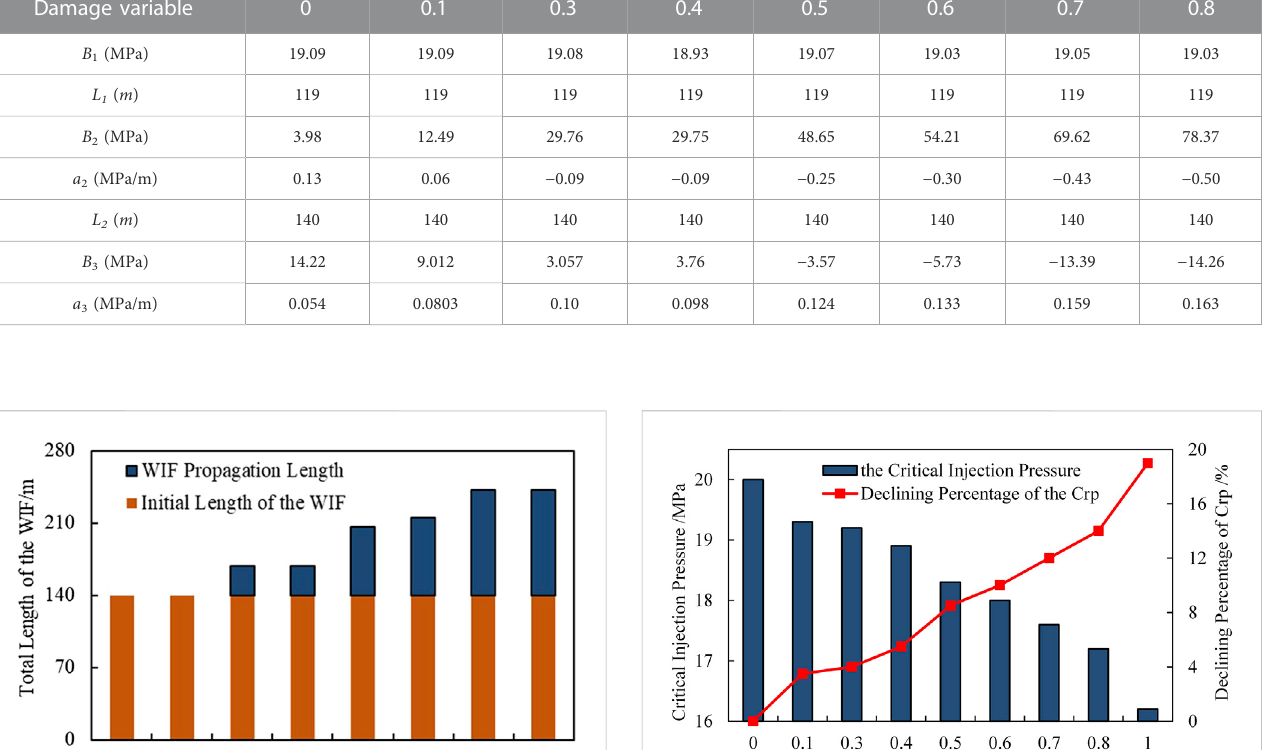
TABLE 4 Parameters of the stress distribution for cases of WIF with different damage variables. Damage variable